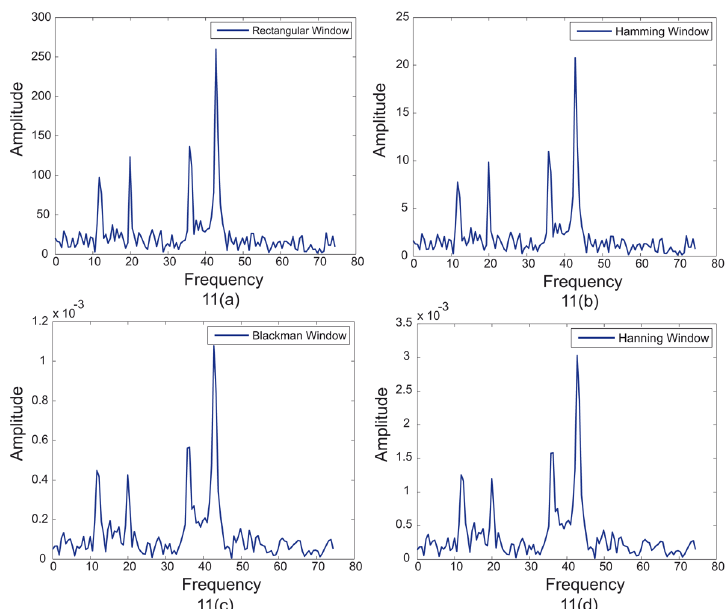
Figure 11. Effect of windowing on signal containing far interfering frequency component (cultural noise). (a) Effect of Rectangular window on a signal with frequency components 43 Hz, 36 Hz, 20 Hz which interact with a random noise of frequency 12 Hz. (b) Effect of Hamming window on the same data set. (c) Effect of Blackman window on the same data set. (d) Effect of Hanning window on the same data set. All windows have similar frequency resolution for this far interfering frequency after FFT.